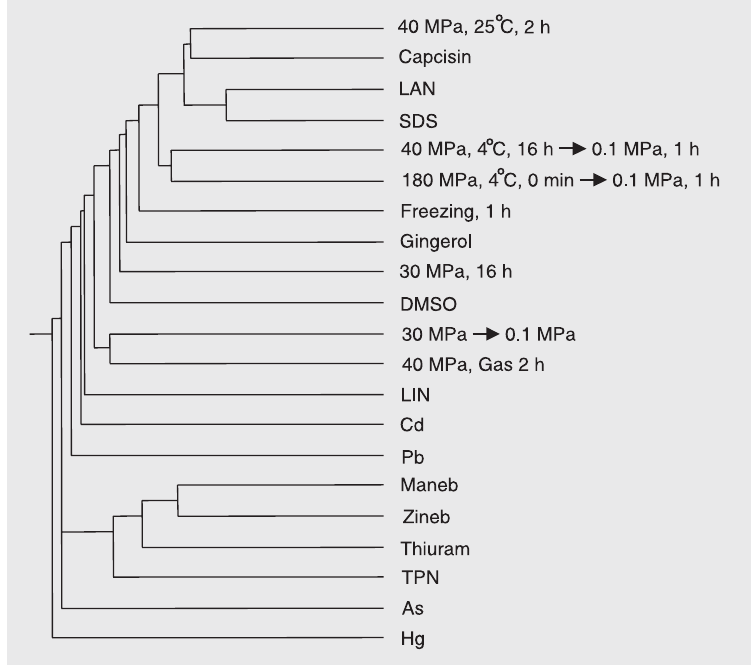
Figure 1. Cluster analysis of expression profiles following treatment of yeast with com-